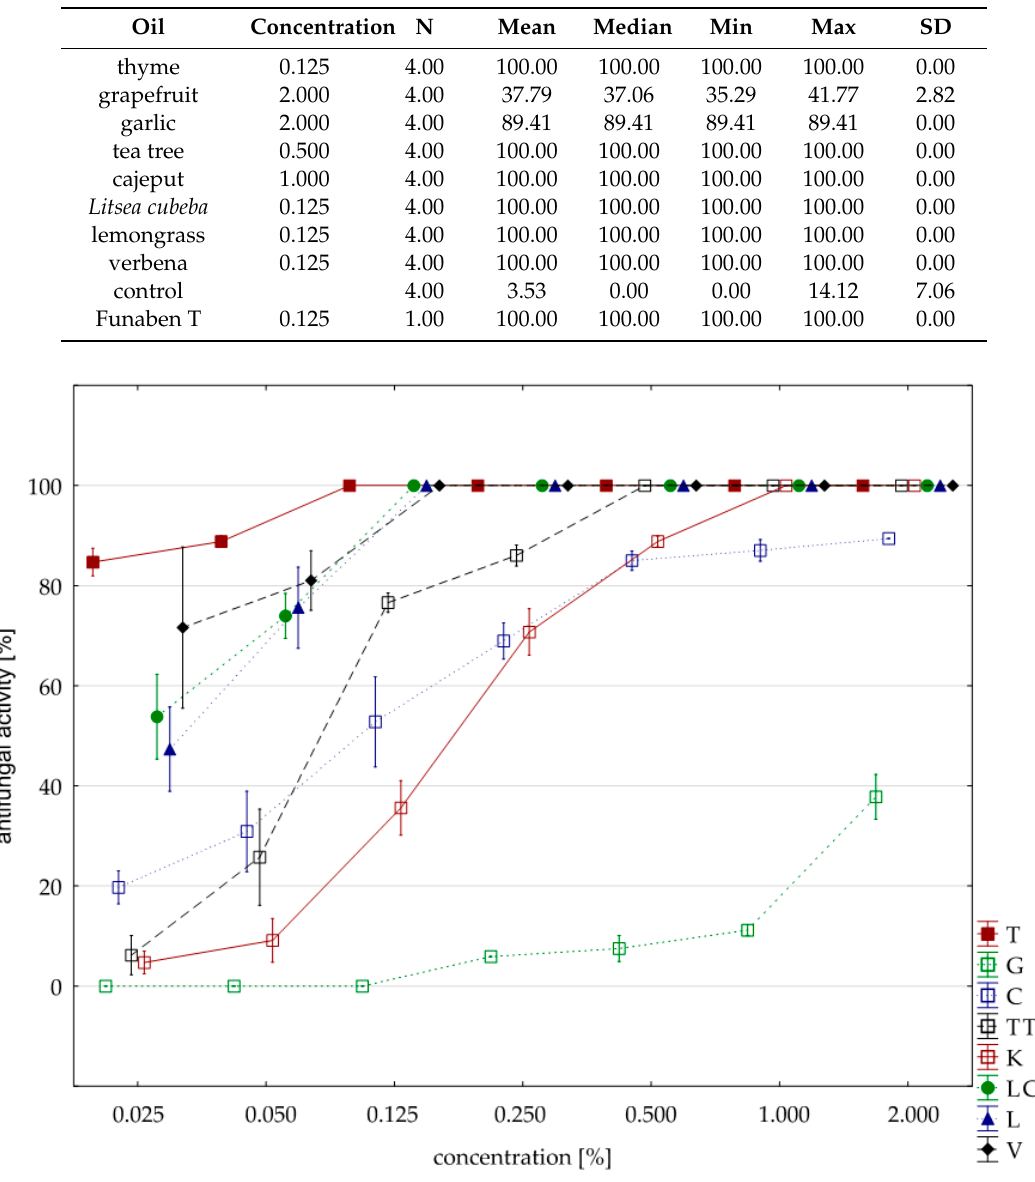
Table 8. Maximum fungistatic activity of the analyzed oils at minimum concentration of the isolate of F. oxyporum .